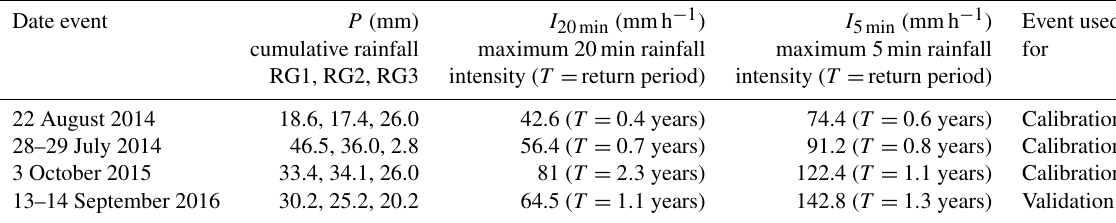
Table 1. Events used for calibration and validation of the urban drainage model.